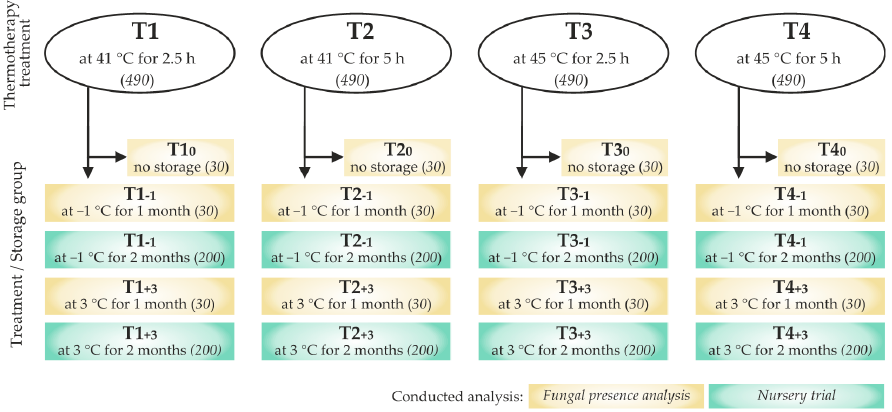
Figure 1. Scheme of Quercus robur acorn groups exposed to different thermotherapy treatment and storage conditions, used for the analysis of fungal presence, and for the nursery trial (group labels are given in bold, numbers of used acorns are given in brackets in italic).